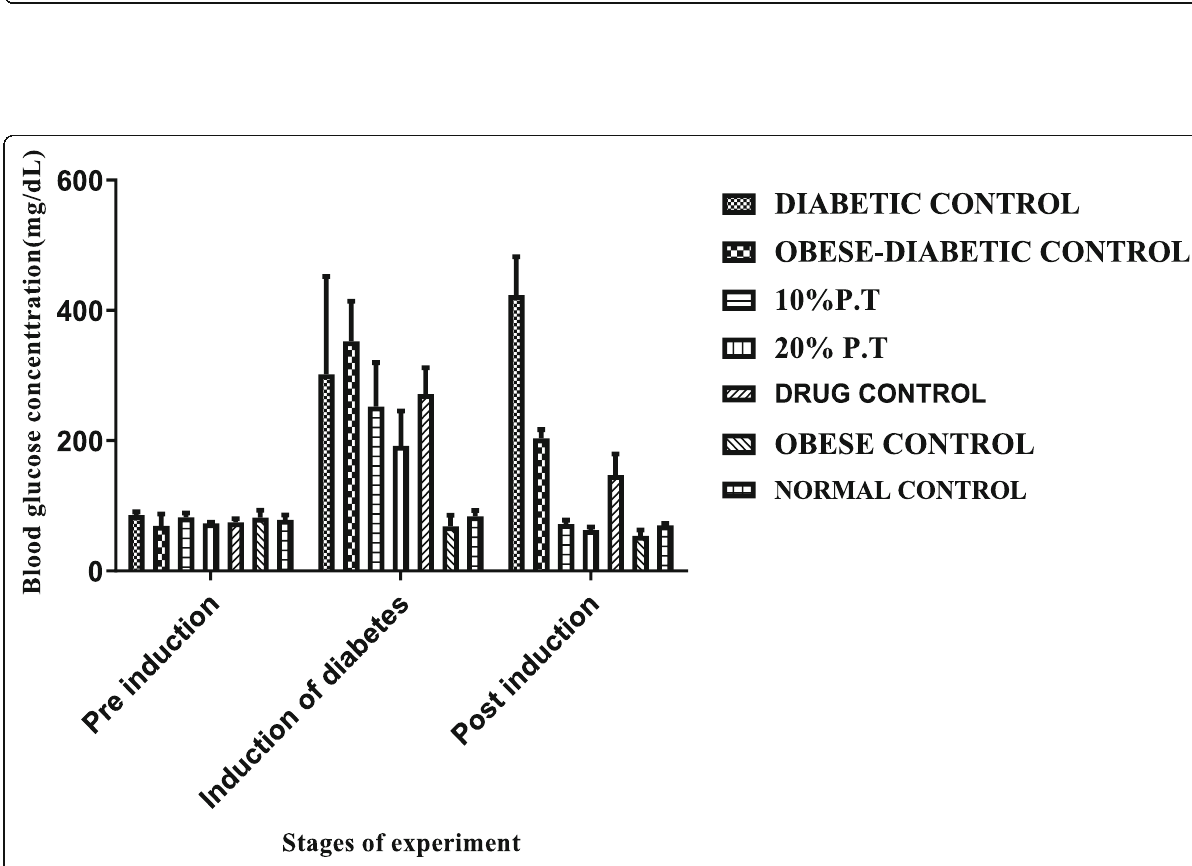
Fig. 2 Blood glucose concentration of treated streptozotocin induced rats. P. T ( Pleurotus tuber-regium), G = (Glibenclamide),A